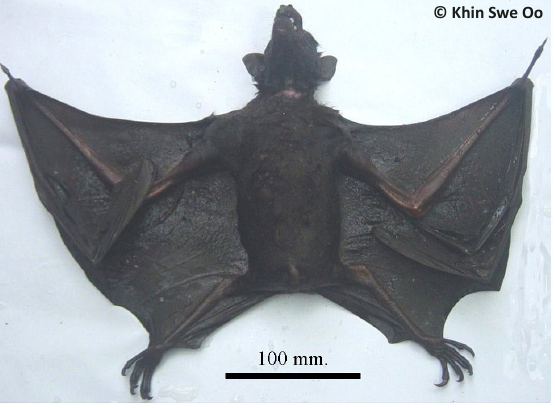
Image 1. Ventral aspect of specimen no. MU/150709001.